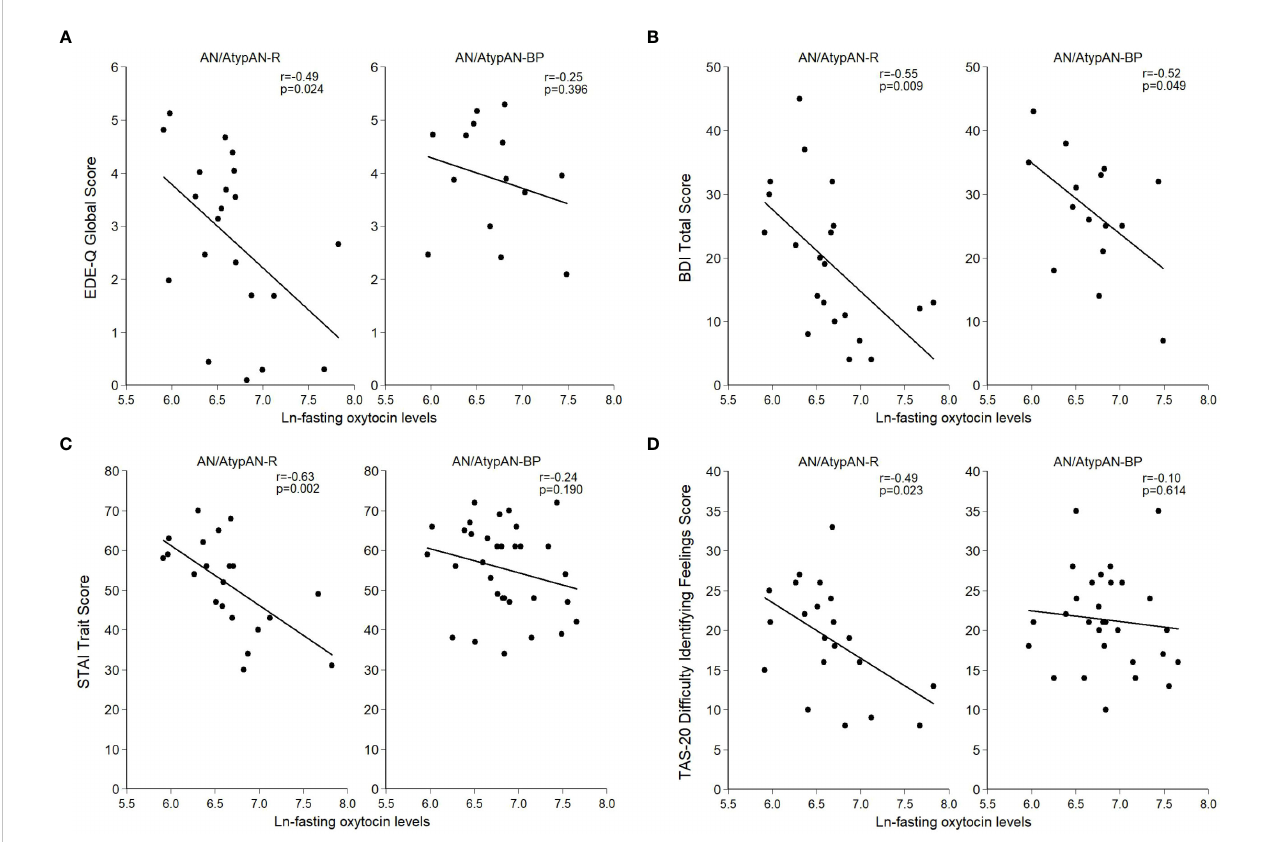
FIGURE 1 Relationship between (log-transformed) fasting oxytocin levels and psychopathology in women with anorexia nervosa (AN)/Atypical AN who are solely restricting (AN/AtypAN-R) and those who restrict in combination with binge/purge behaviors (AN/AtypAN-BP). (A) Eating Disorder Examination – Questionnaire (EDE-Q) Global Score (eating disorder psychopathology); (B) Beck Depression Inventory-IA (BDI) Total Score (depressive symptoms); (C) State-Trait Anxiety Inventory (STAI) Trait Score (anxiety symptoms); and (D) Toronto Alexithymia Scale (TAS-20) Dif fi culty Identifying Feelings Score (socioemotional